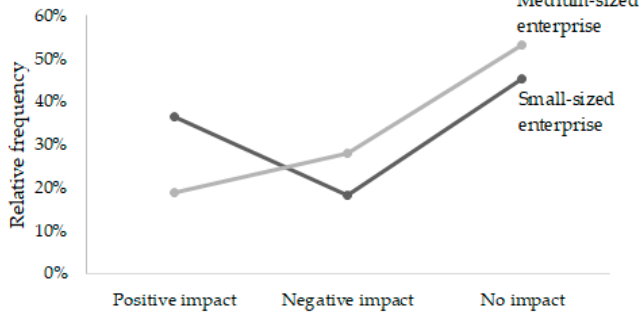
Figure 8. Interaction plot of the relative frequencies of the categories of the impact of the COVID-19 coronavirus pandemic on the company’s innovation activities grouped by the size of the family